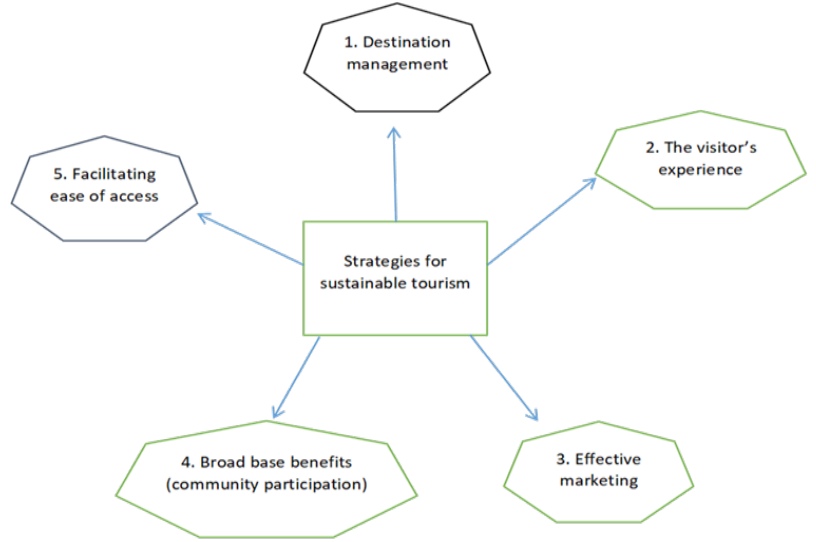
Figure 1: Strategies Employed for The Sustainability of Township Tourism by UNWTO (2017)